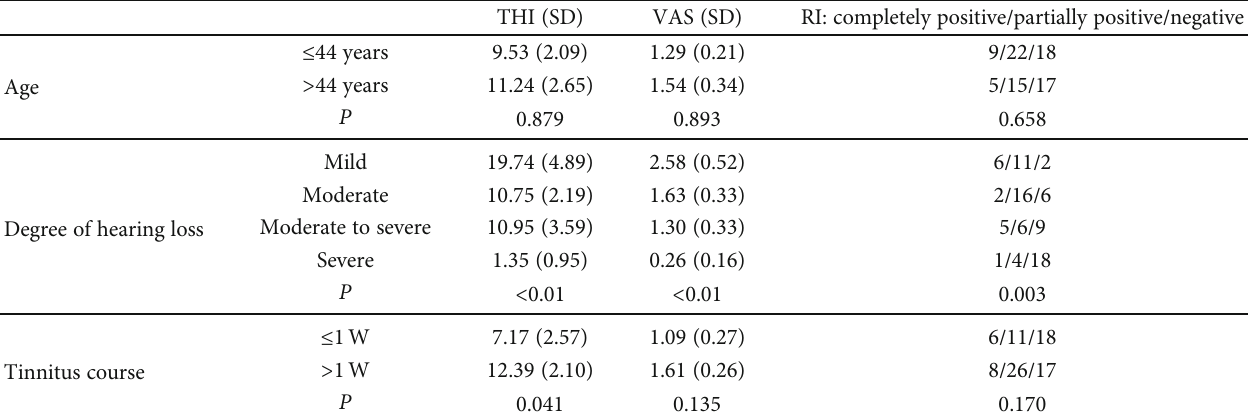
Table 2: The comparison of THI, VAS, and RI of